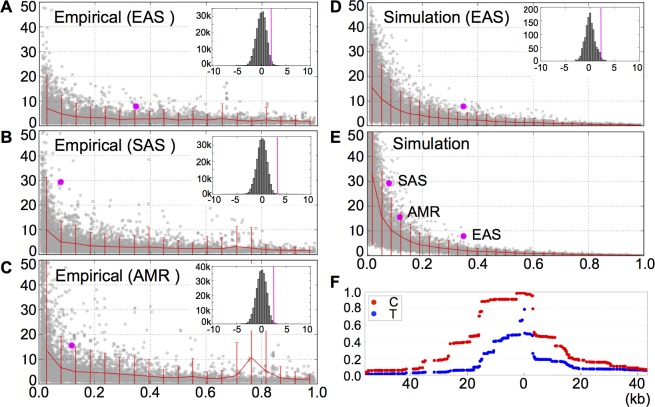
Relative extended haplotype homozygosity (REHH) of the CGC-type in EAS, SAS and AMR.REHH values are plotted against core allele frequencies. (A–C) Observed REHH values (magenta dots) and empirical distributions in chromosome 15 for EAS, SAS, and AMR. For a given frequency at a core SNP, red lines indicate the 95th percentile. Each inset depicts the empirical distribution of standardized ln(REHH) for genome-wide SNPs with allele frequencies comparable to the CGC-type (chromosomes 3–5 and 7–22). The magenta lines indicate the observed values. (D) The observed REHH value for EAS (magenta dot) together with the simulated distribution under the demographic model of changing population size [17] (10,000 replications). The inset shows the standardized ln(REHH) distribution for SNPs with derived allele frequencies comparable to the CGC-type. Simulation is based on 1,200 replications (the observation is indicated by the magenta line). (E) Observed REHH values for EAS, SAS, and AMR (magenta dots) together with the distributions simulated by ms (under the standard neutral model with 10,000 replications). (F) Decay of EHH from SNP3 (at 0 location) in EAS.